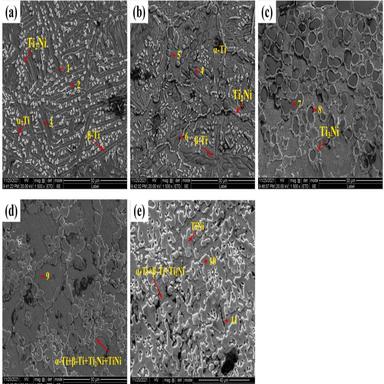
The microstructure of the gradient layers by SEM: (a) 85% Ti6Al4V + 15% Inconel 625; (b) 80% Ti6Al4V + 20% Inconel 625; (c) 75% Ti6Al4V + 25% Inconel 625; (d) 70% Ti6Al4V + 30% Inconel 625; (e) 65% Ti6Al4V + 35% Inconel 625.